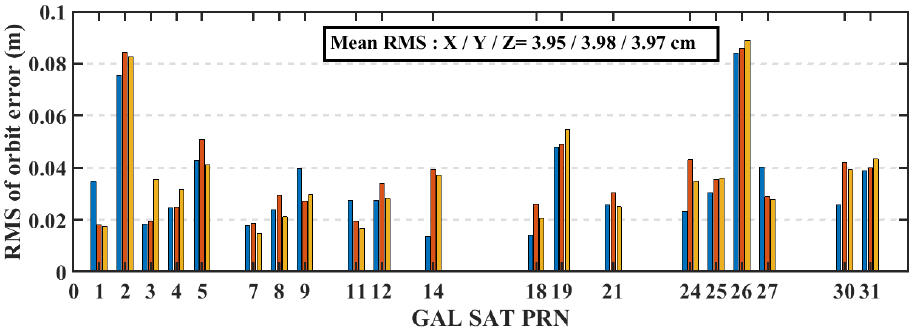
Figure 3. RMS of GPS satellites ’ orbits based on NAVCAST real-time products.